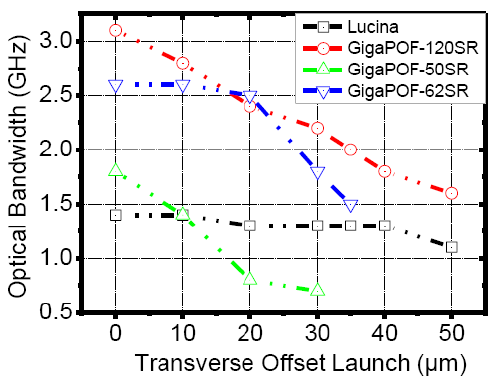
Figure 10. Optical Fiber modal bandwidth measurement as a function of the transverse offset launch. The measurement has been performed in a restricted mode launch condition